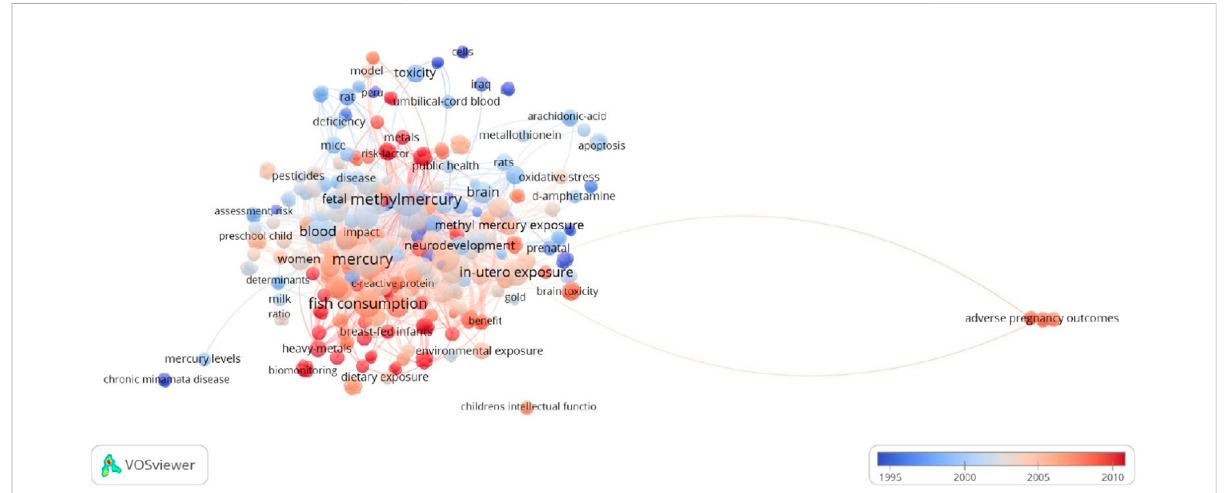
FIGURE 3 Overlayvisualization ofkeywords connectedbyco-occurrence.Networkoftheall-keywordsdistributionalongtheyearsofpublications(color scale) of the top 100 most-cited papers about maternal exposure to MeHg and offspring health